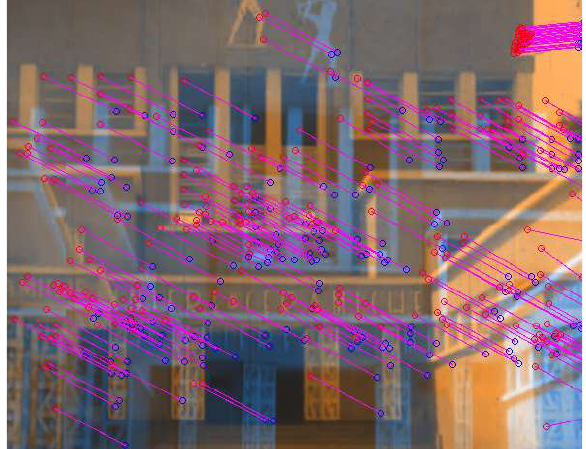
Figure 6. Visualization of matching result: tie points between two images, the first one coloured in blue and the second in orange